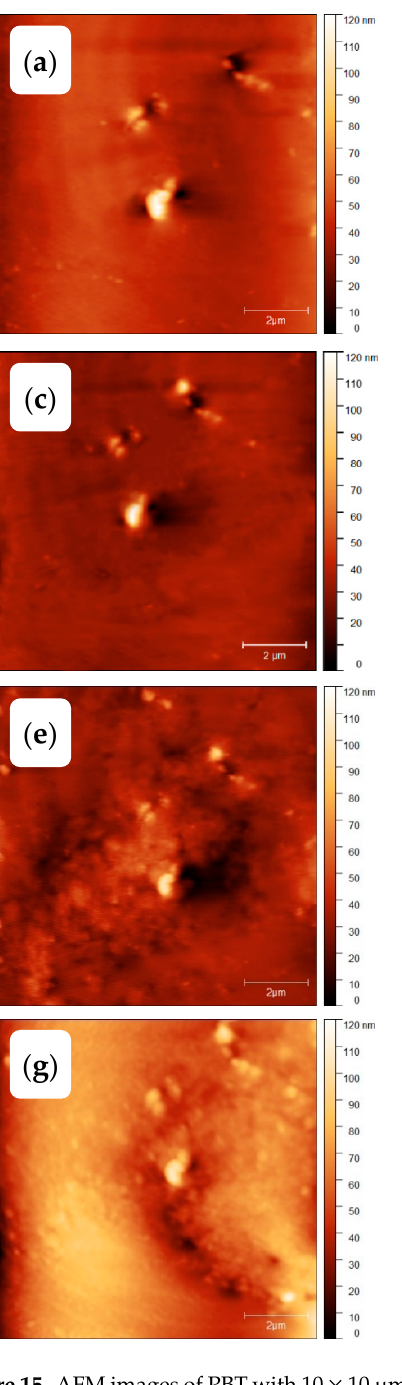
Figure 15. AFM images of PBT with 10 × 10 µ m 2 scan area. The sample was quenched ( a , b ), annealed at 290 K for 10,000 s ( c , d ), annealed at 490 K for 1 s ( e , f ) and annealed at 290 K for 10,000 s and at 490 K for 1 s ( g , h ). The left images ( a , c , e , g ) show the topology and the right images ( b , d , f , h ) amplitude differences.